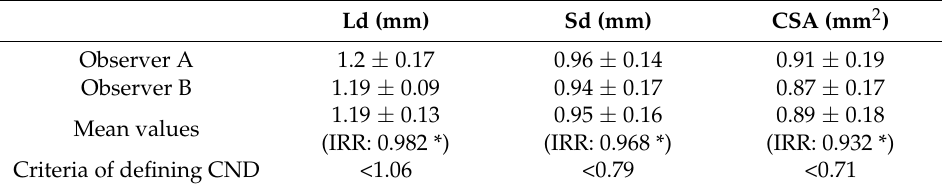
Table 1. Inter-rater reliability in the measurement of mean values of cochlear nerve size in the normal ears and criteria of defining